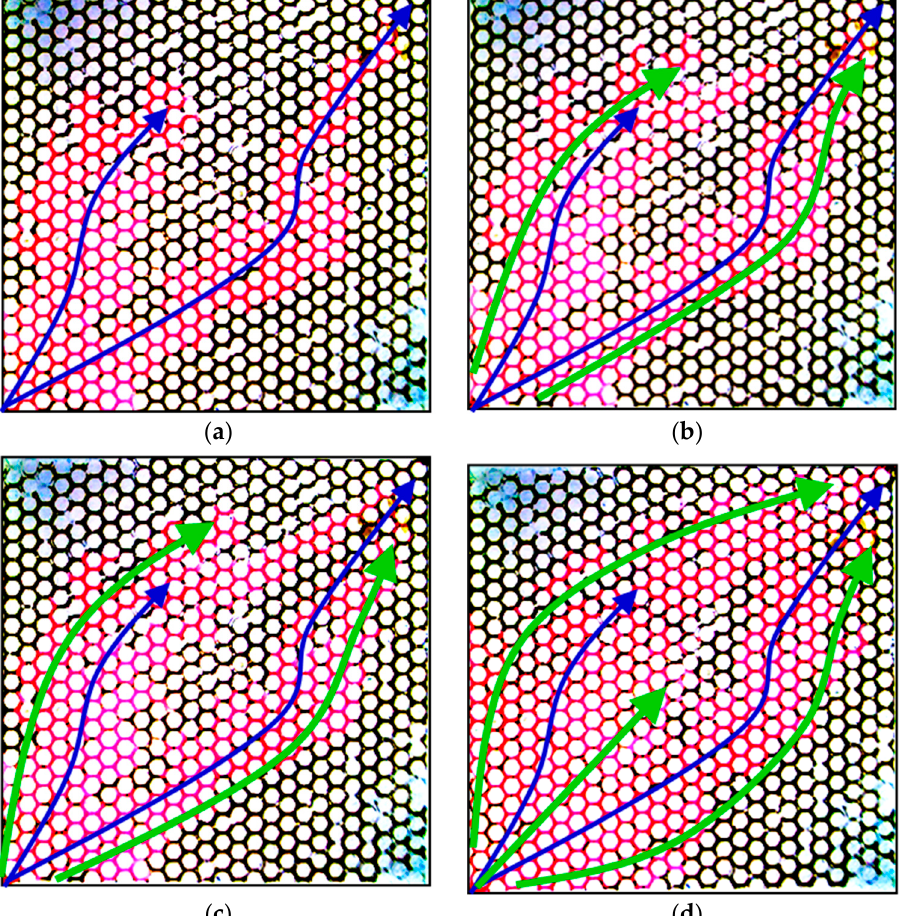
Figure 7. Micrographs of oil displacement experiment using PPG of 2–4 Pa, 120–150 mesh: ( a ) end of water flooding, ( b ) 0.25 PV of PPG flooding, ( c ) 0.5 PV of PPG flooding and ( d ) end of PPG flooding.